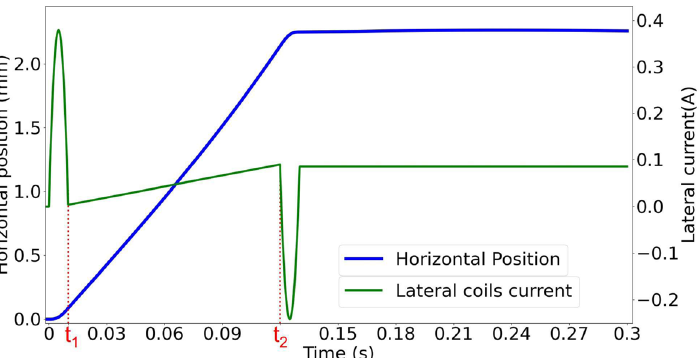
Figure 3. The controlled motion of the sphere in the horizontal plane. The motion of the sphere along the horizontal direction is plotted in blue (thicker line), the left axis being the displacement of the sphere. The green line represents the driving current applied to the lateral coils to induce the rectilinear movement, the magnitude of the current is indicated on the right axis.